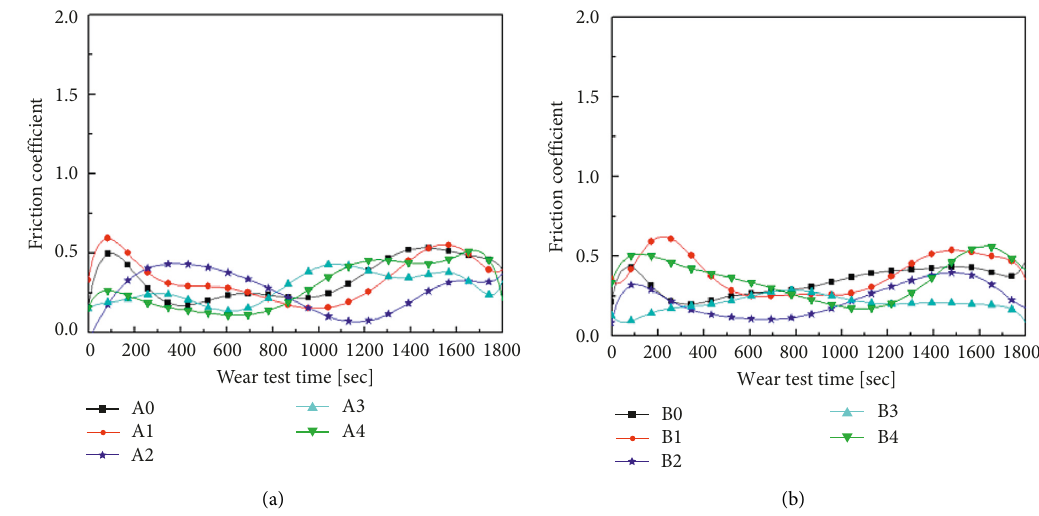
Figure 5: Friction coefficient curves by deposition conditions: (a) A0 ∼ A4; (b) B0 ∼ B4.